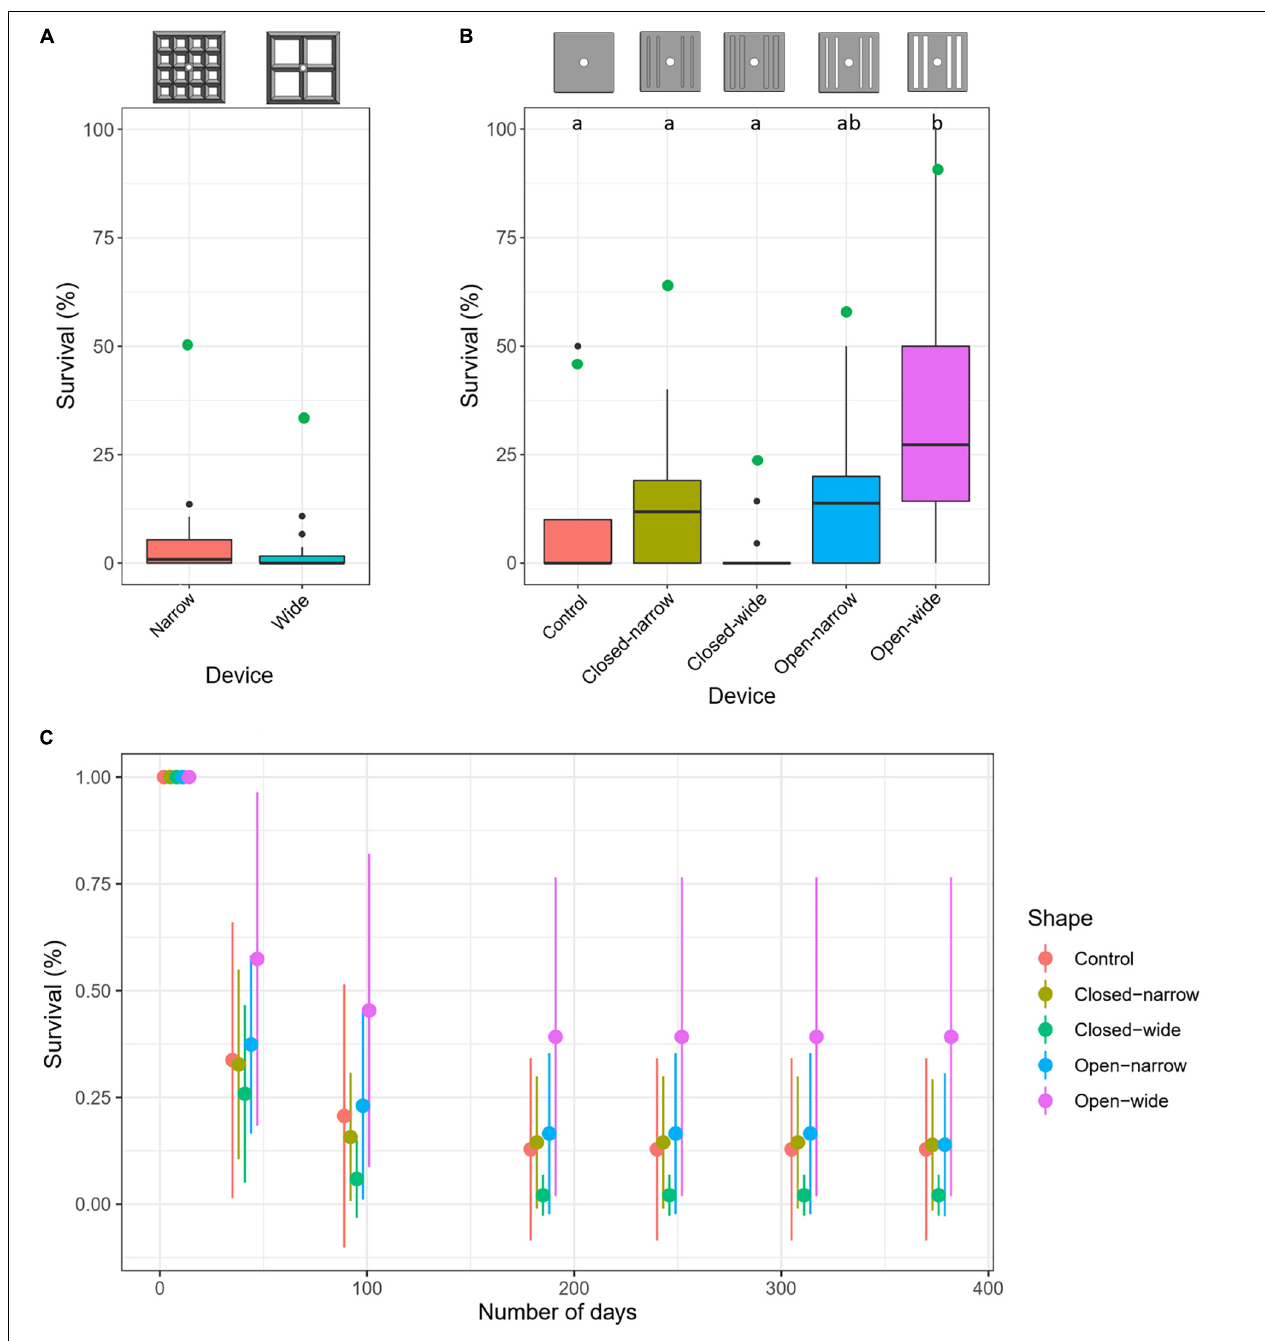
FIGURE 4 | Average survival (%) of Acropora tenuis spat after approximately 1 year deployed in the field on two types of lattice-grids (A) and on five types of grooved-tiles (B) . Letters (a and b) in panel (B) indicate statistically significant differences in survival among treatments. (C) Average ( ± SD) spat survival through time on the five types of grooved-tiles. Reference diagrams of each device type are included above the plots in panels (A) and (B) . Overlaid green points in panels (A) and (B) indicate survival (%) at the device-level (i.e., having at least one surviving recruit on the device at the end of deployment).